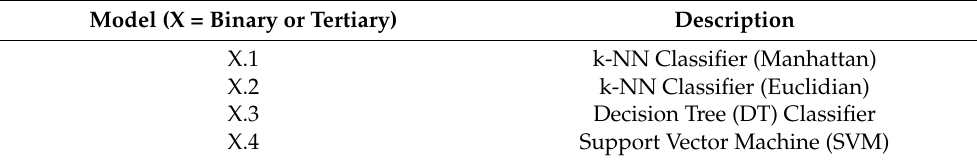
Table 4. A list of machine learning models used and their associated